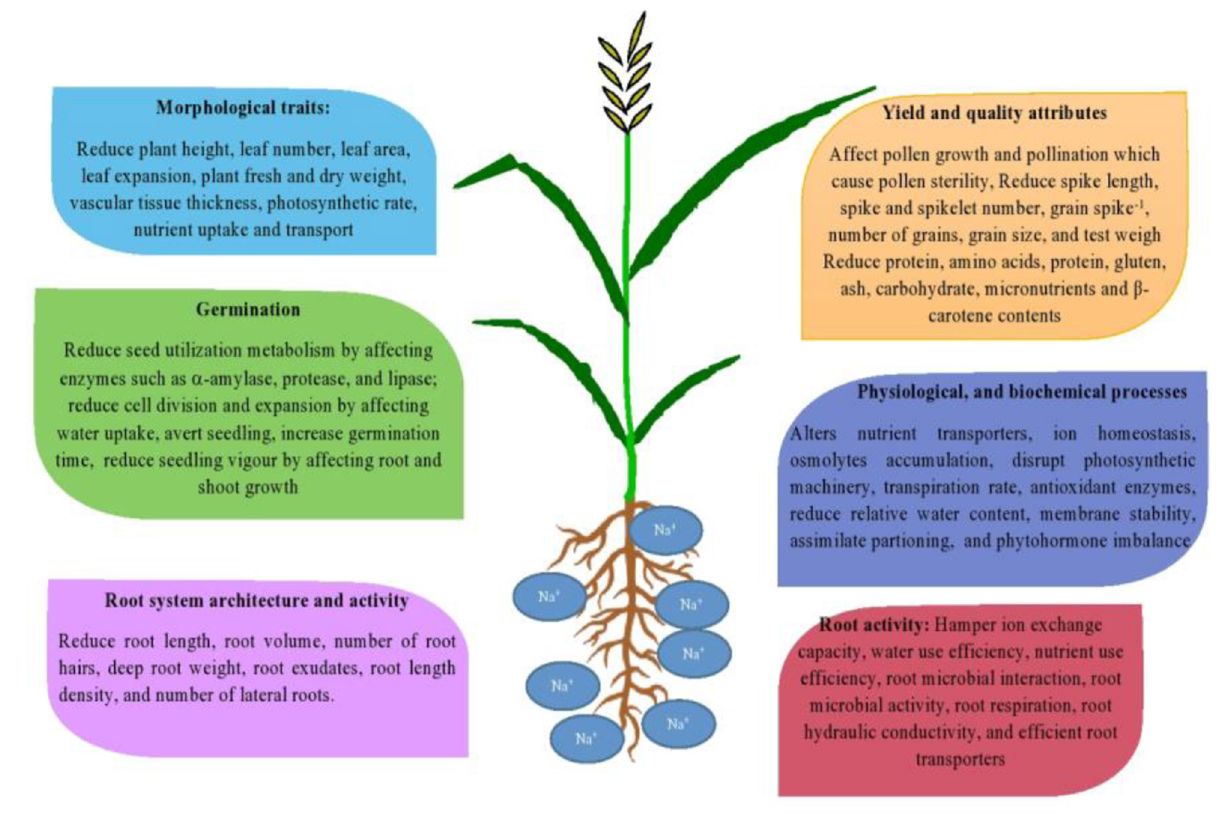
to preserve crop productivity through the optimal regulation of growing conditions of cereal crops. There is dire need to develop strategies such seed priming with natural or synthetic